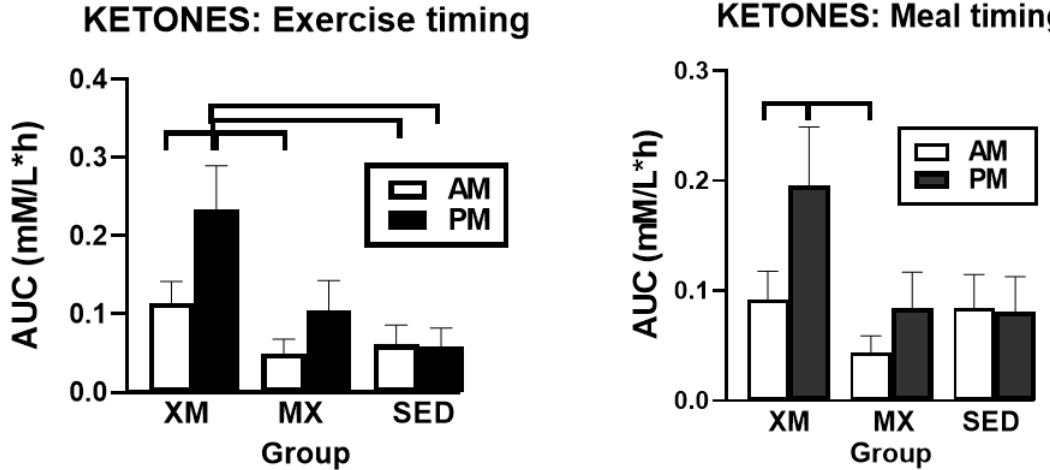
Figure 4. Exercise- and meal-timing effects on BHB exercise and prandial AUCs. Exercise-timing AUCs represent 2 h of exercise and one post-exercise hour. Meal-timing AUCs represent 7 postprandial hours.In the exercise analysis, afternoon XM ketone AUC was significantly higher than AM MX and both AM and PM SED AUCs. Within XM trial, afternoon AUC was higher than the AM AUC ( left panel). In the prandial analysis, afternoon XM ketone AUC was significantly higher than AM MX AUC and the AM AUC within its own trial ( right panel). Brackets identify groups with significant between- and within-group differences. XM = exercise before meals, MX = exercise after meals, SED = sedentary group.